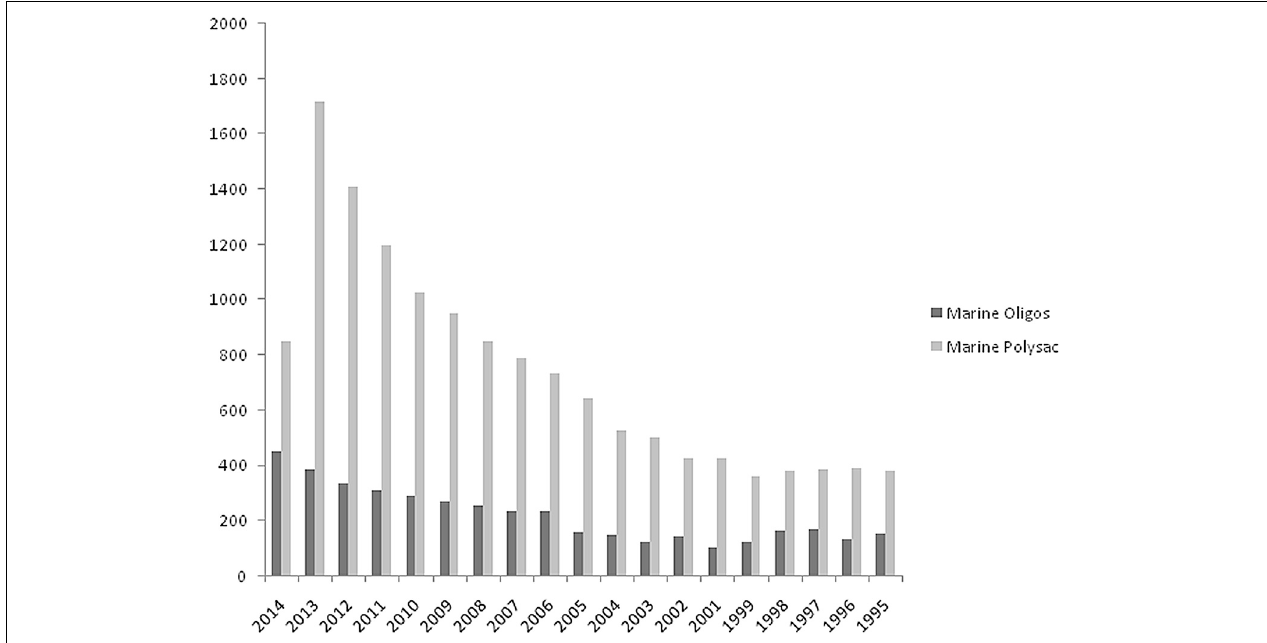
FIGURE 1 | Number of total hits searching for “marine oligosaccharides” and “marine polysaccharides” using Advanced Search feature of Science Direct a commercial database offering ca. 2500 journals and 20,000 books. Searches are conducted in all fields